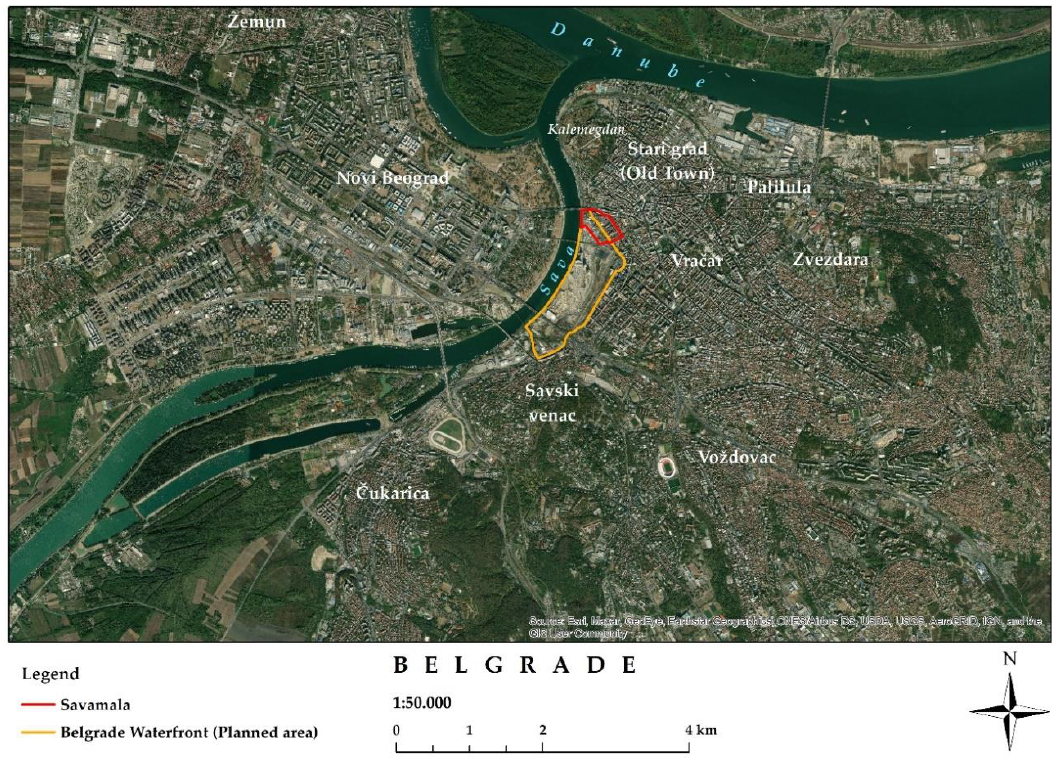
Figure 1. Neighbourhood Savamala and planned area of the Belgrade Waterfront within Belgrade.